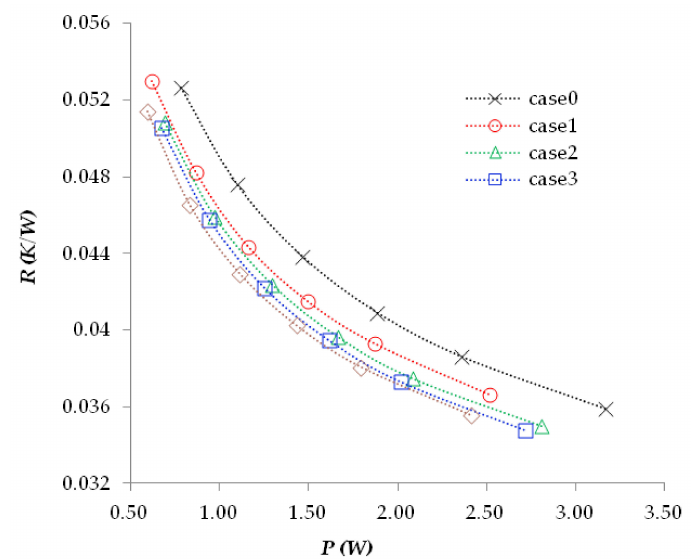
Figure 13. Total thermal resistance of different pumping power of the four microchannel sinks after